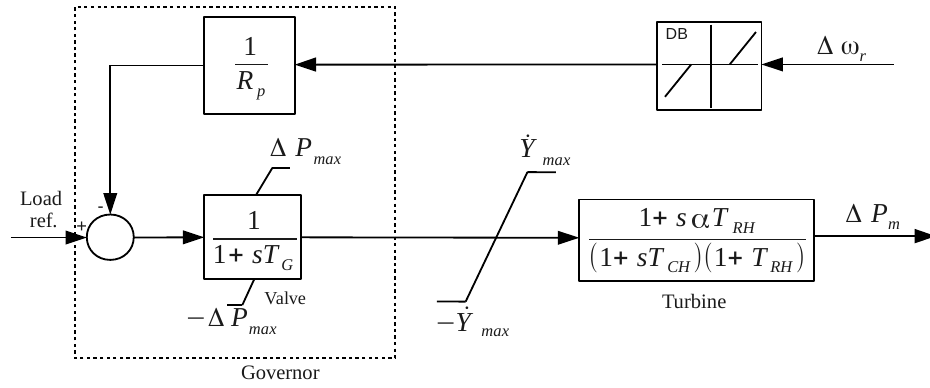
Figure 3. Model of the thermal plant.